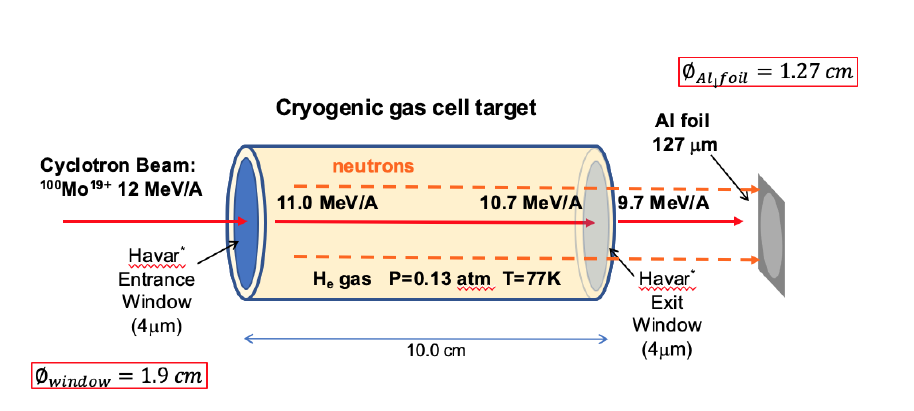
Figure 1. Schematic diagram of the irradiation setup. A 100 Mo beam at 12 MeV / nucleon enters the gas cell and interacts with the helium gas. The heavy reaction products, including 99 Mo, after exiting the gas cell are implanted in the Al catcher. The energies of the beam are listed as it passes through the entrance window, the gas target and the exit window.